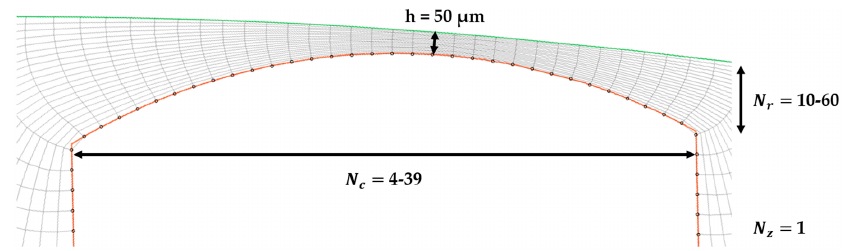
Figure 6. Meshing parameters in the radial gap region.